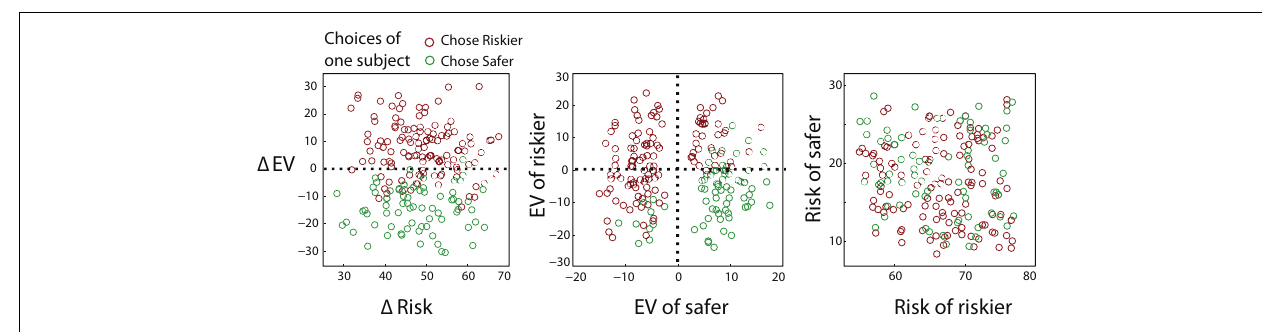
FIGURE 3 | Trials were chosen to give a spread of expected values ( EV s) and a spread of risks. One gamble always had a high risk, and the other a low risk. On some trials the choice was easy (small EV